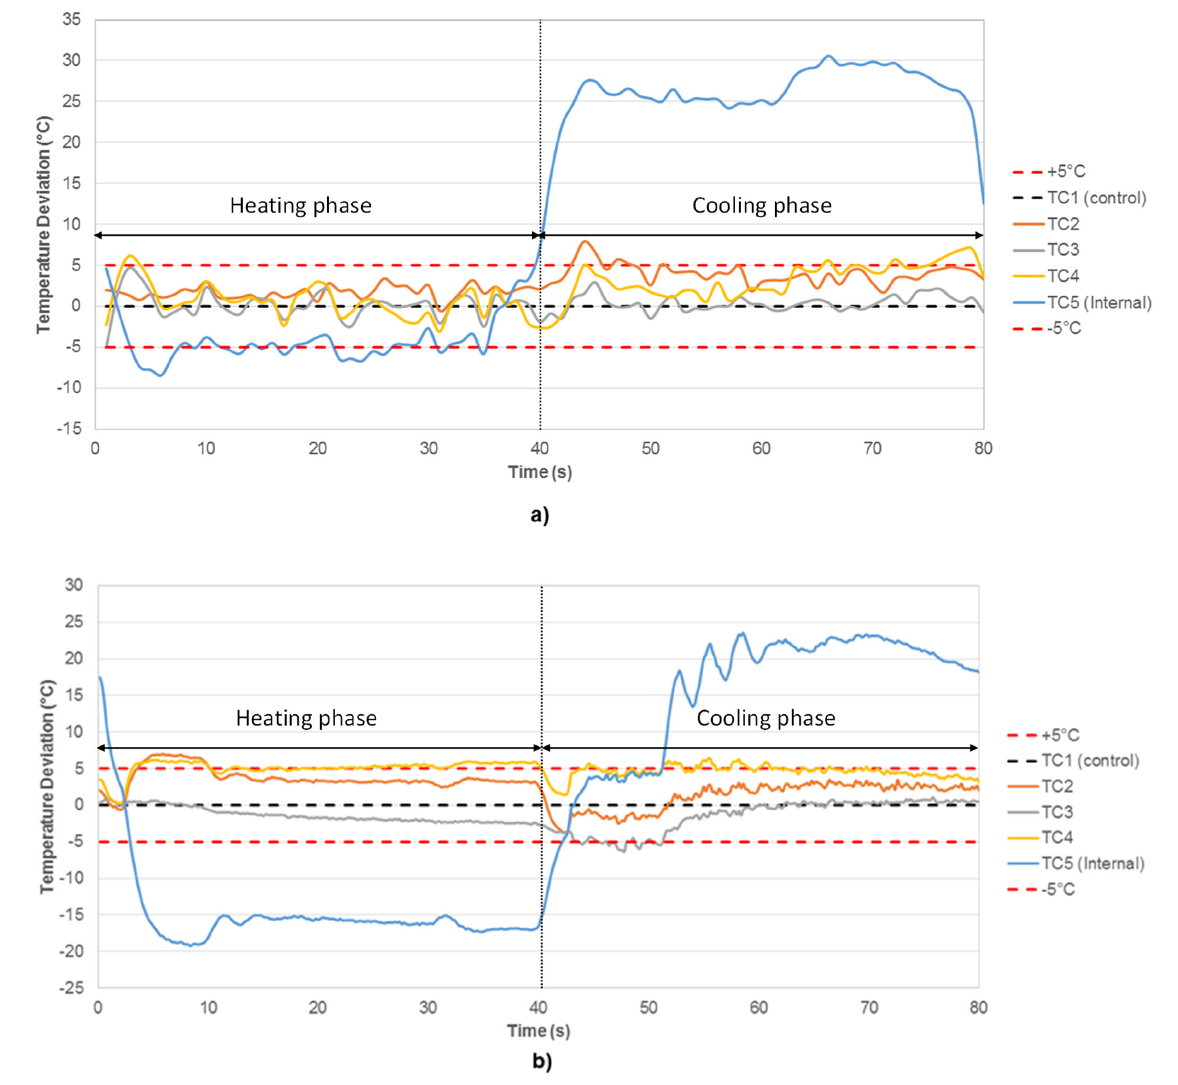
Figure 3. Temperature deviation over the period of an 80 s cycle using ( a ) ICS and ( b ) RLF, showing a temperature gradient on cooling of the specimen in both cases.